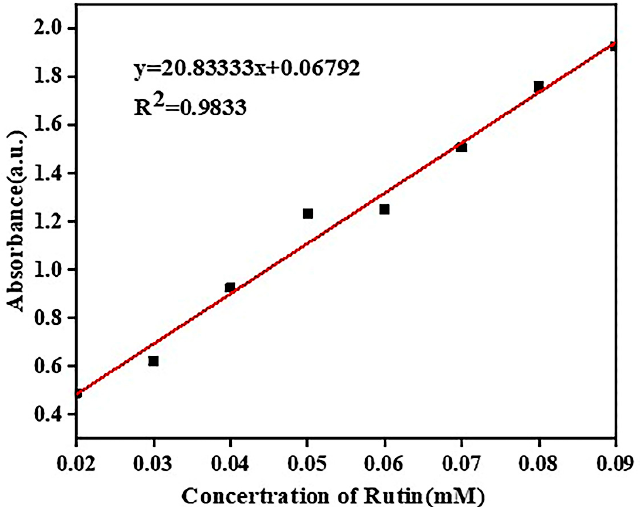
Figure 6. Standard curve of rutin.